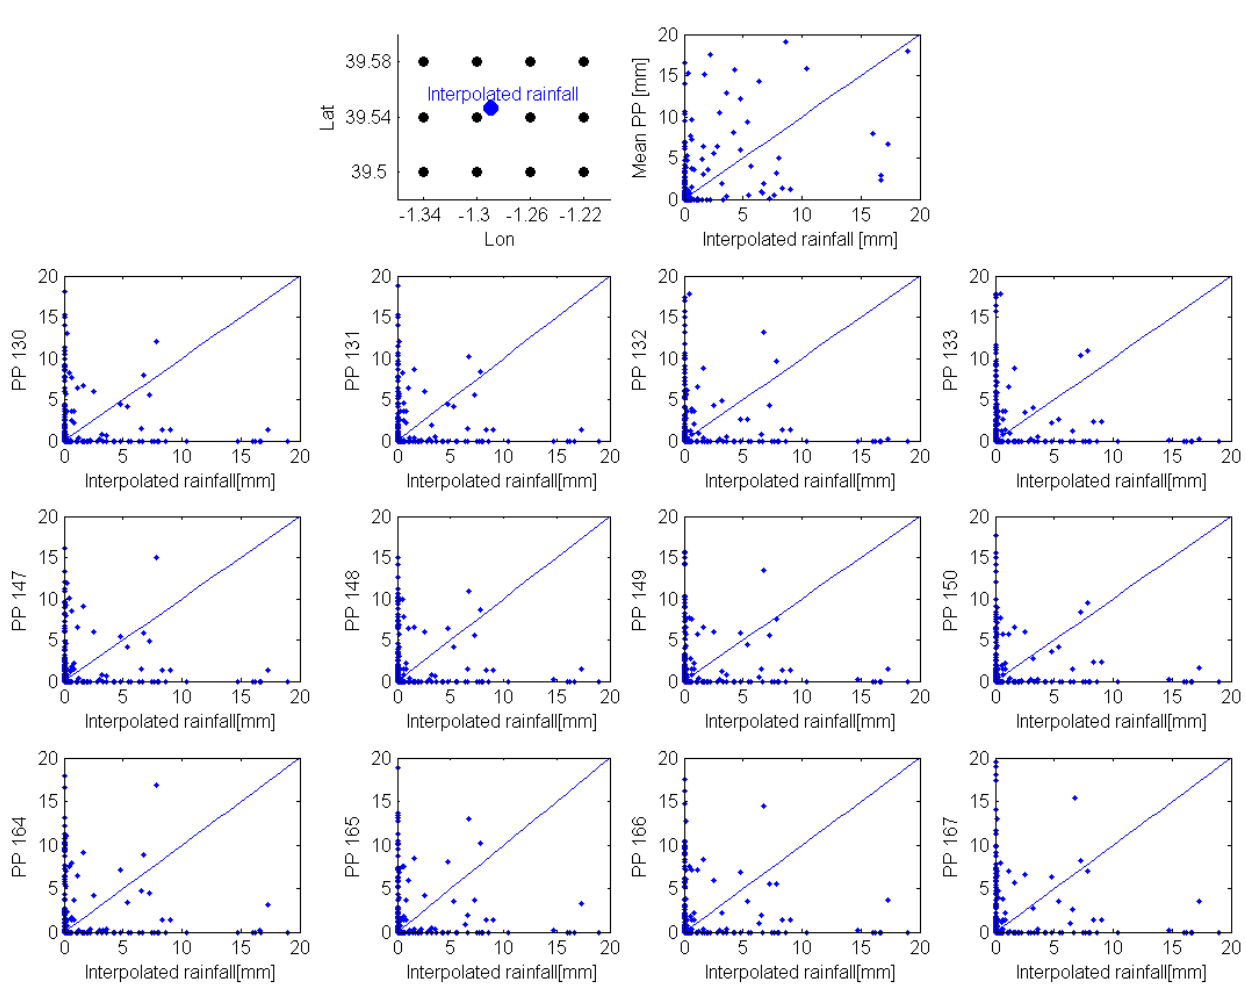
Fig. 4. Comparison between interpolated rainfall product ( x -axis) and PERSIANN points ( y -axis). The interpolated rainfall is representative over a 10 × 10km 2 area and is obtained using in situ observations over VAS. The mean PP represents the spatial average of the 12 PERSIANN points available within the same grid as the interpolated rainfall. The top left figure provides a map (longitude x -axis, latitude y -axis) representing the interpolated rainfall and the PERSIANN points, while the top right figure represents the comparison between the interpolated rainfall and the PERSIANN mean. The 2nd, 3rd and 4th rows present comparisons of the interpolated rainfall ( x -axis) and each PERSIANN point ( y -axis). The analysis is done for 2007 at a daily scale.